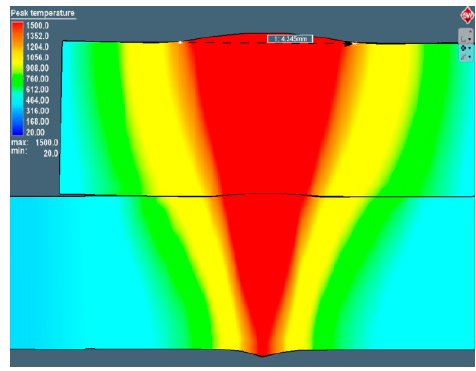
Figure 7. Laser lap-joint welding results from ( a ) simulation, ( b ) experiment.